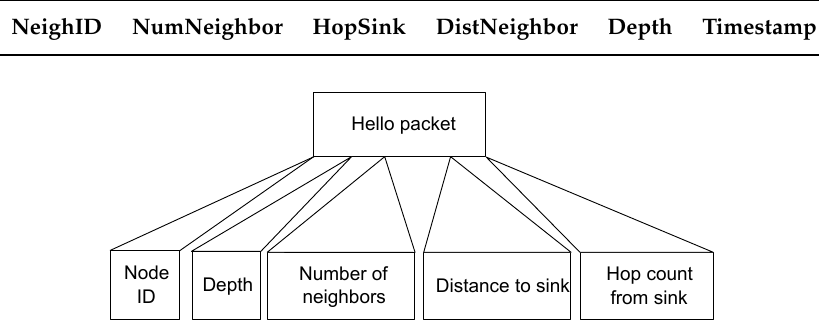
Table 2. Format of neighbor table.